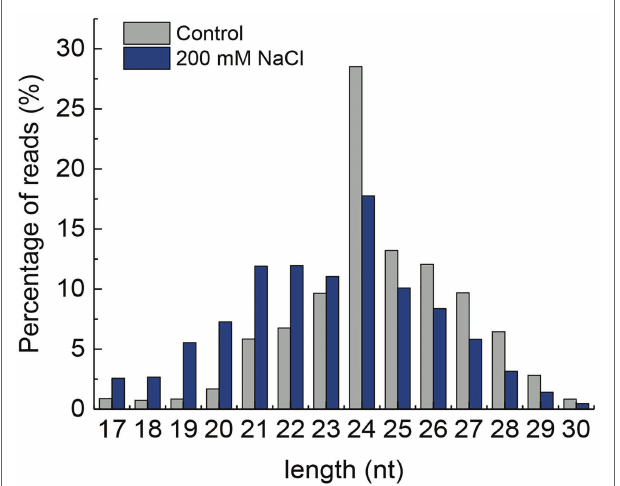
FIGURE 2 | Length distribution of small RNAs in the QM6 roots under 200 mM NaCl-induced salt stress and control conditions. Y -axis, the percentage of small RNA reads.